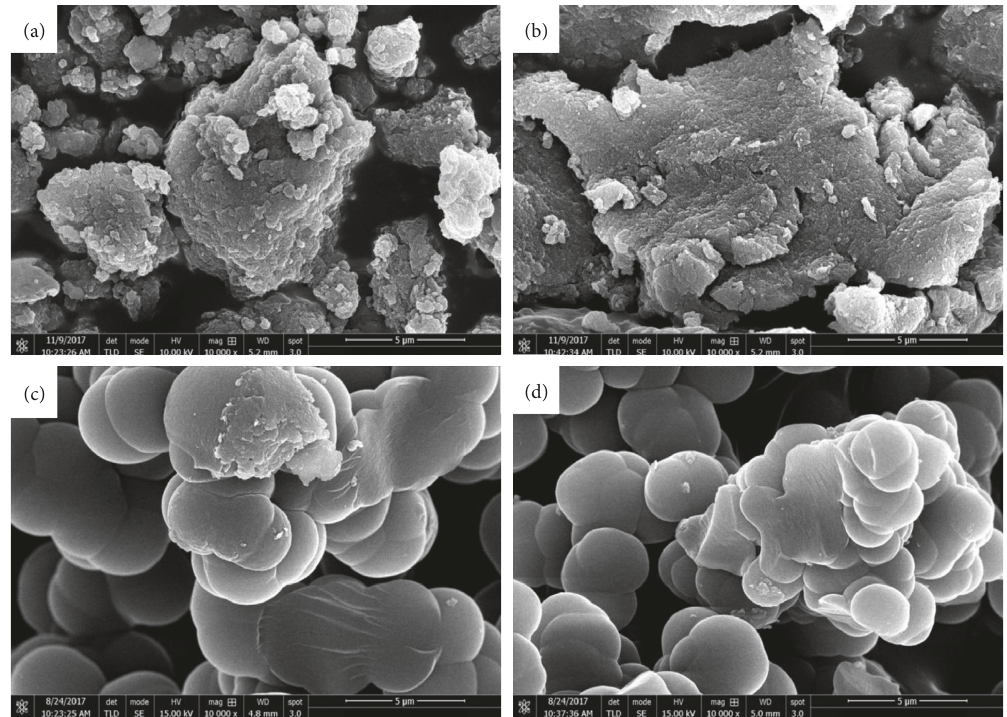
Figure 1: SEM micrographs of DESs-MIPs (a), DESs-NIPs (b), methanol-MIPs (c), and methanol-NIPs (d).